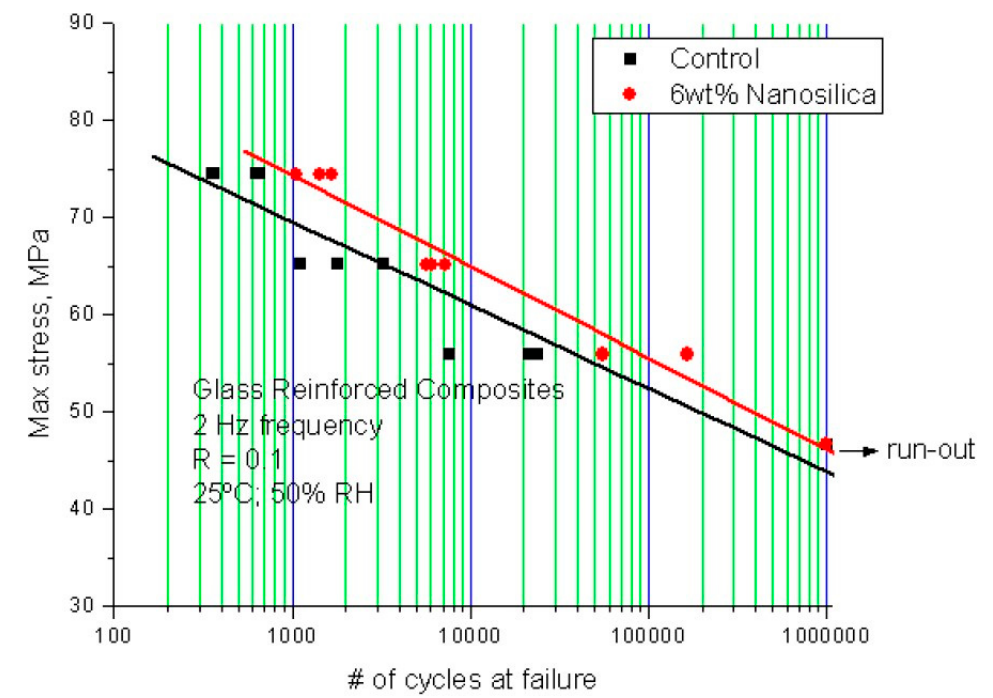
Figure 16. Stress versus number of cycles until failure (S–N) curves for unmodified and 6 wt % SiO 2 -containing epoxy GFRC [67].